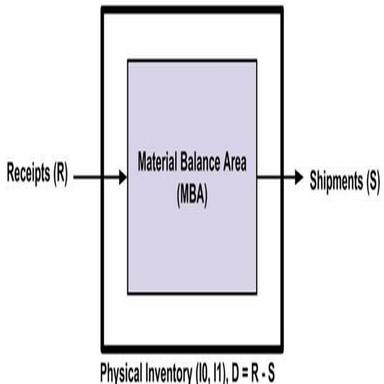
A material balance area can be defined around one or multiple subprocesses. The material throughput (D) is calculated by subtracting the receipts (R) by the shipments (S). The initial inventory (I0) and the final inventory (I1) are used to calculate ID for an MBA containing inventories.